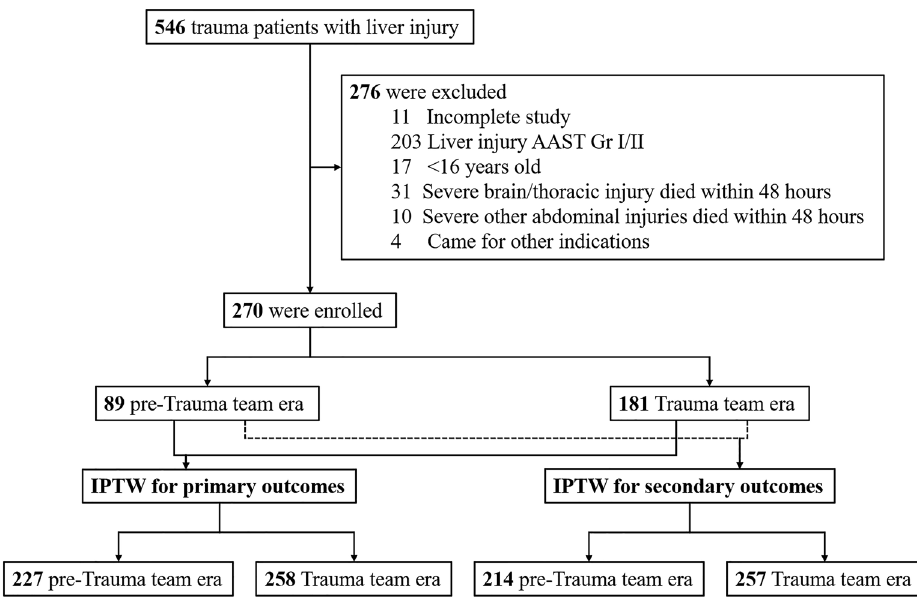
Figure 1. Diagram of study stratification according to propensity score